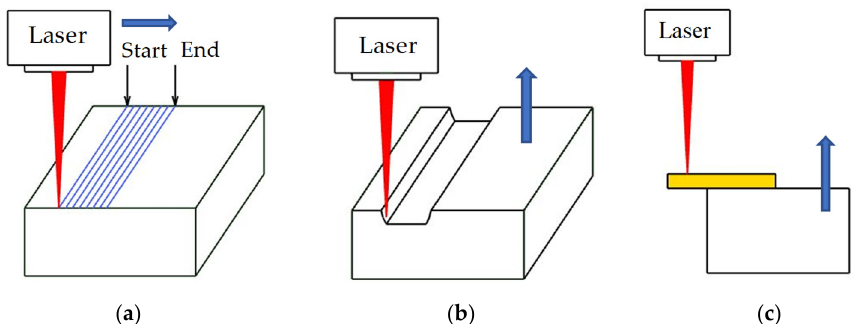
Figure 2. Schematic diagram of laser cutting: ( a ) Laser cutting paths, cut from the start (Path 1) to the end (Path 8). After Path 1 is traversed, the laser beam is shifted 10 µm to the right to cut Path 2. The total number of shifts is seven with total shifting of 70 µm to the right. ( b ) After the first layer is cut, the laser beam is switched back to the position of the first path; the workpiece is lifted by 50 µm along the Z-axis, and the cutting process is repeated as described in ( a ) until the workpiece is cut through. ( c ) Schematic of fixing the workpiece with an overhang. The workpiece and stage holder can be simultaneously lifted along the Z-axis.